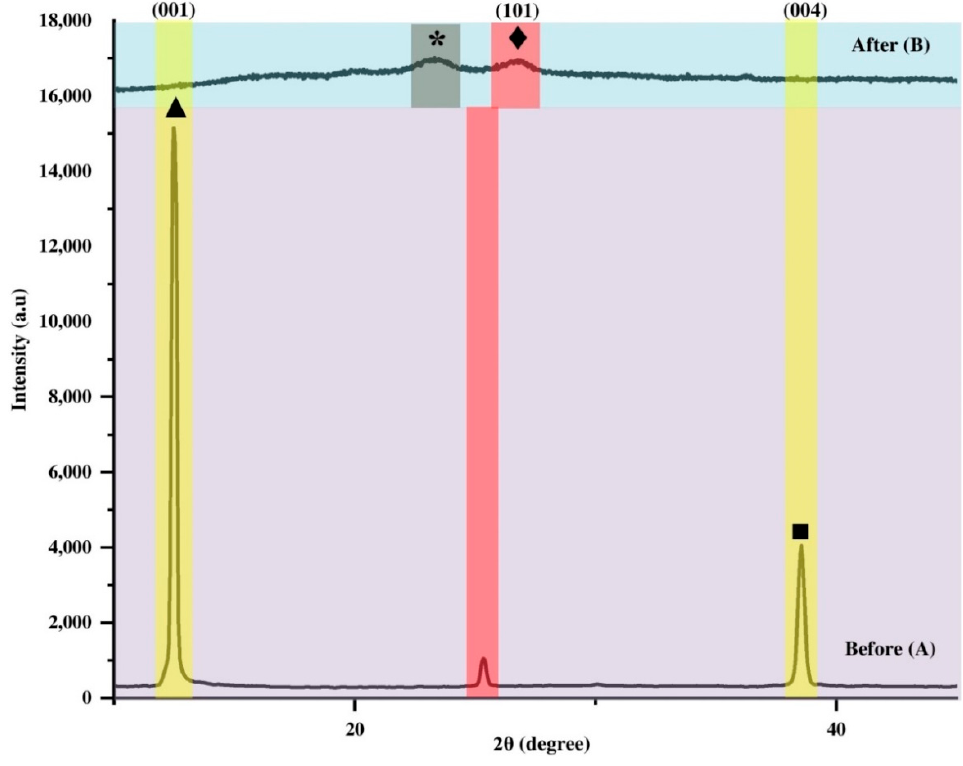
Figure 11. XRD spectrum of I ‐ AMP with ▲ , ♦ , ■ and ⁎ representing PbI 2 (001), perovskite (101), TiO 2 (004) and new phase peak recorded before (A) and after exposure (B).